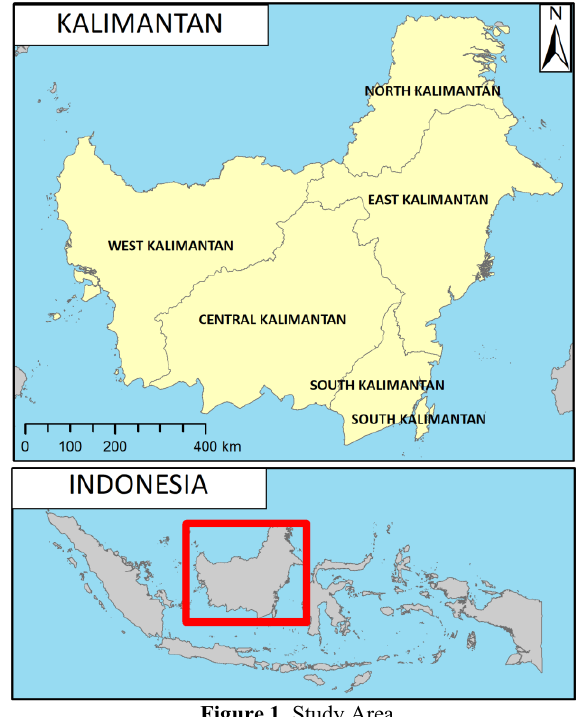
Figure 1 . Study Area